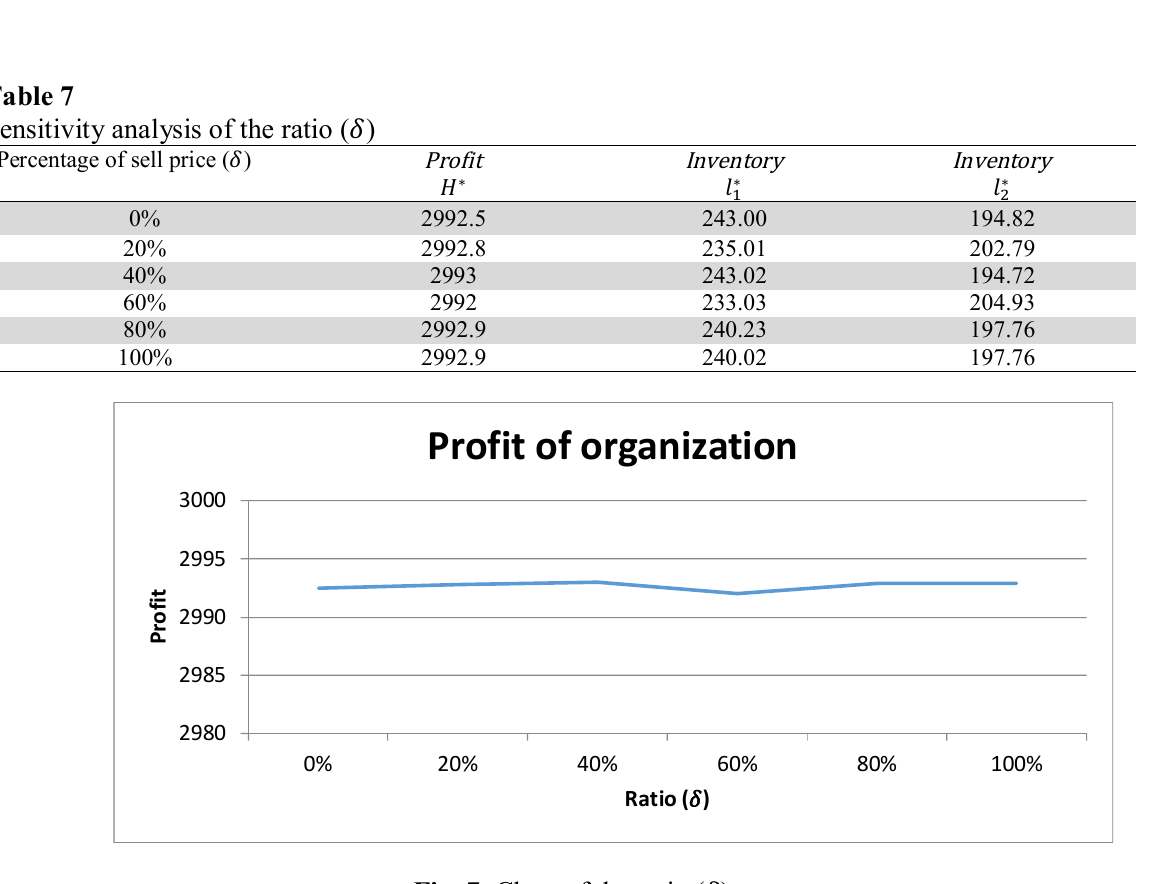
Fig. 6. Chart of the ratio ( (cid:2010) )